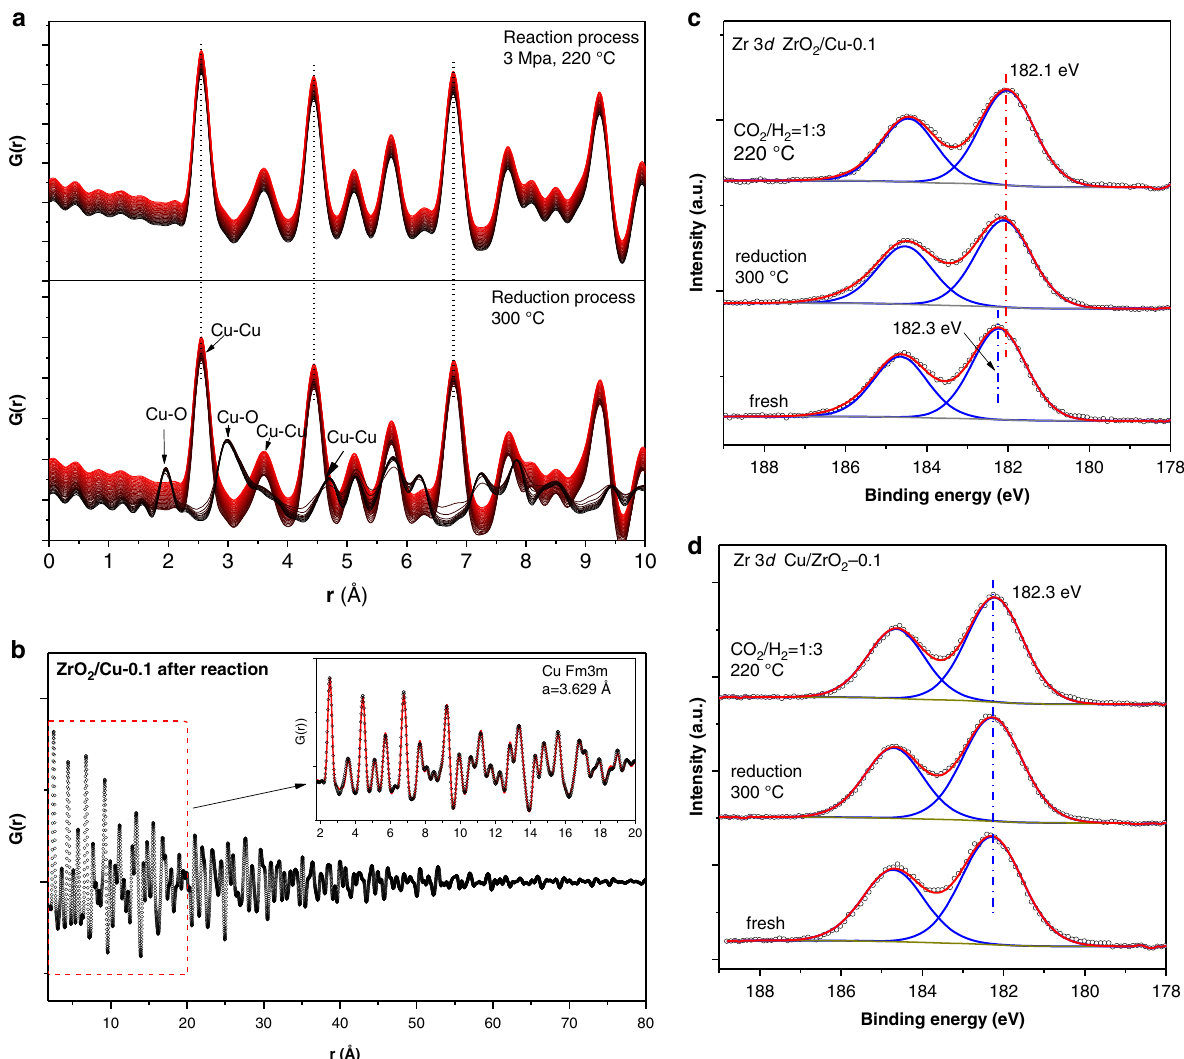
Fig. 3 In situ characterizations for the ZrO 2 /Cu catalysts. a Pair distribution function in real space of ZrO 2 /Cu-0.1 catalyst in reduction condition (upper panel; reduced in the fl ow of 5% H 2 /He from room temperature to 300 °C, from black to red) and under reaction condition (bottom panel) (Reaction conditions: 2 ml min − 1 CO 2 + 6 ml min − 1 H 2 , 3 MPa, 220 °C, reaction time: 60 mins; from black to red). b The PDF and fi tting pro fi les (inserted fi gure) of the post reaction ZrO 2 /Cu-0.1 catalyst. The pro fi le exhibited here was the last spectrum of obtained for the in situ reaction in part a. The AP-XPS Zr 3 d region spectra of c ZrO 2 /Cu-0.1 and d Cu/ZrO 2